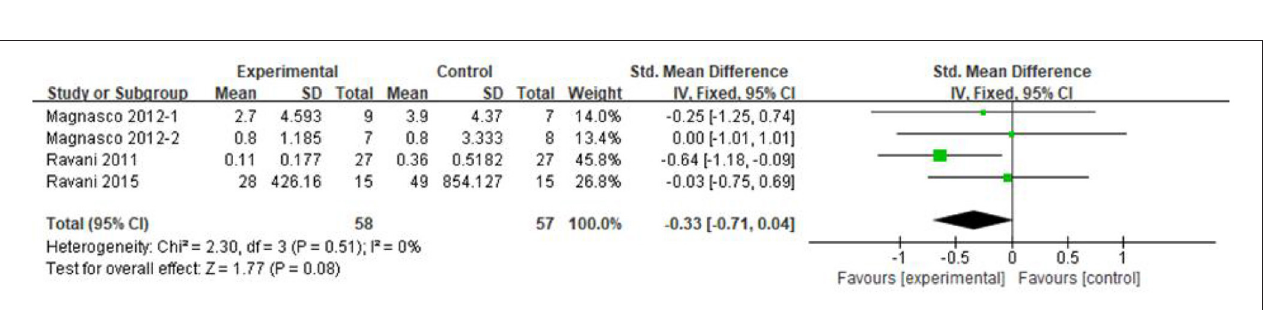
FIGURE 6 | Forest plot showing a meta-analysis for the RTX group vs. control group on the proteinuria excretion.